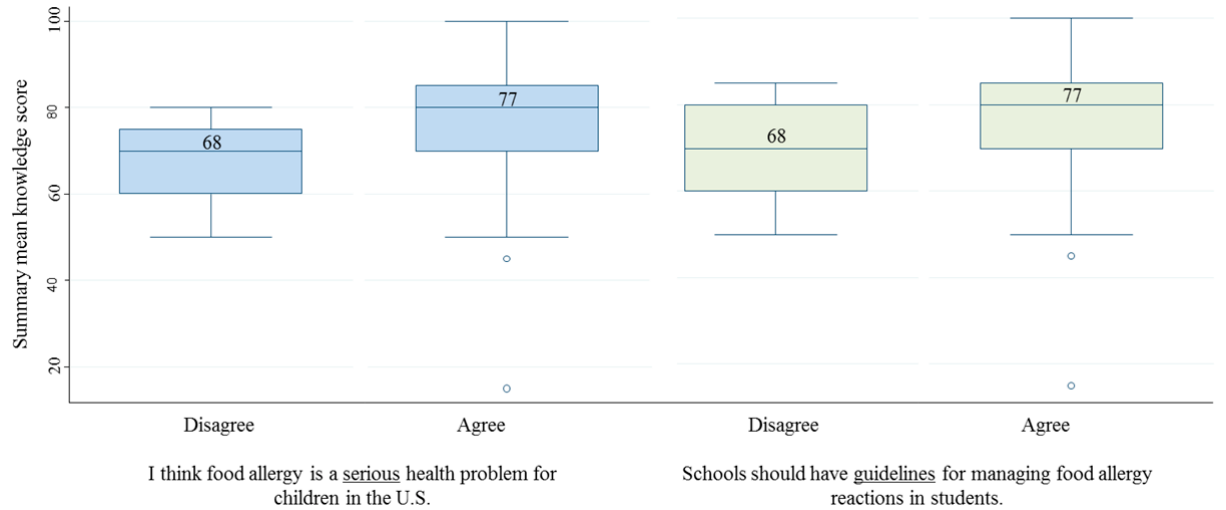
Figure 2. Knowledge scores by nurse